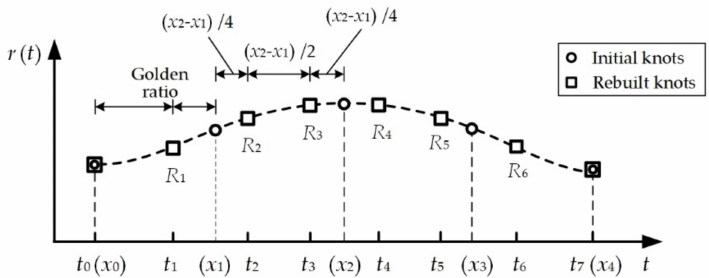
Figure 10. Arrangement for abscissas of newly-built